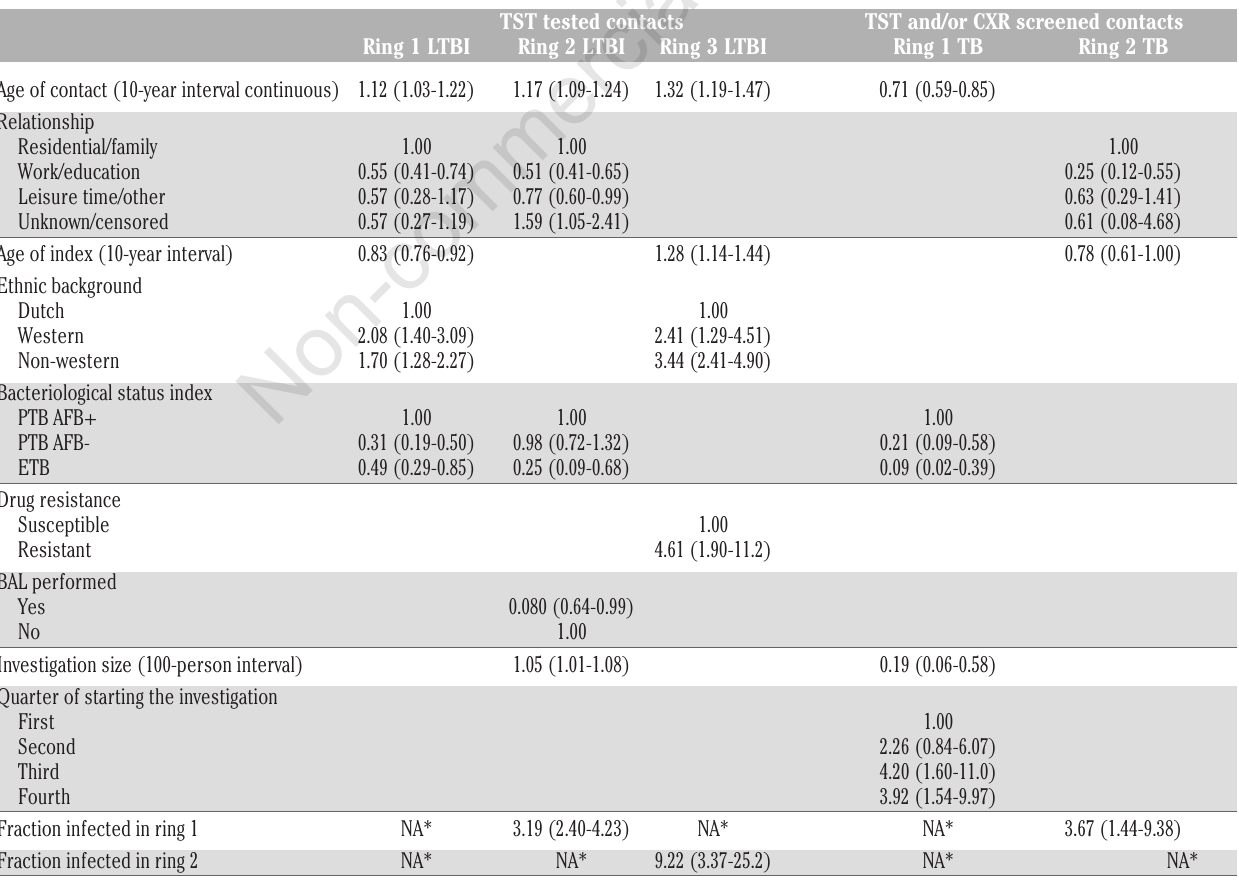
Table 2. Odds ratios and their corresponding 95% confidence intervals for all significant factors in source tracing and contact inves- tigations among contacts of TB patients from the five multivariate logistic regression models. ‘Gender’ did not reach significance in any of the models and is not, therefore, shown. Ring 1 contains close contacts, ring 2 contains regular contacts, ring 3 contains communi- ty contacts.